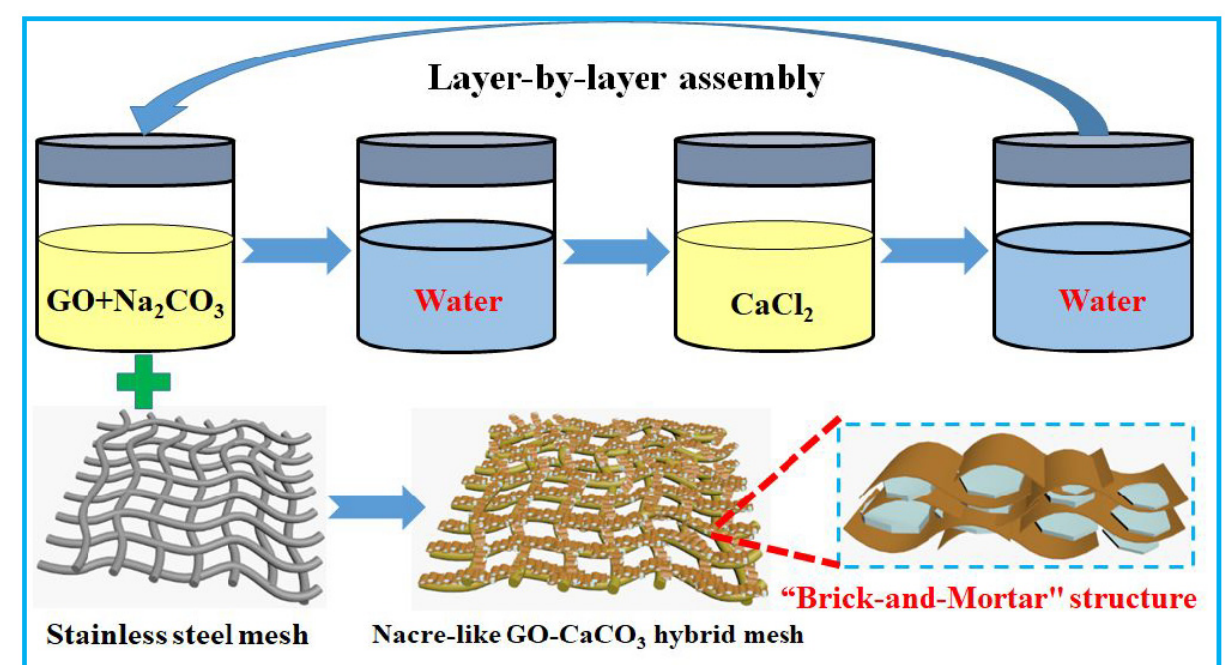
Figure 6. Schematic description of the fabrication of the nacre-like GO-CaCO 3 hybrid mesh for oil–water separation. Reproduced from ref. [24] with permission of the American Chemical Society.